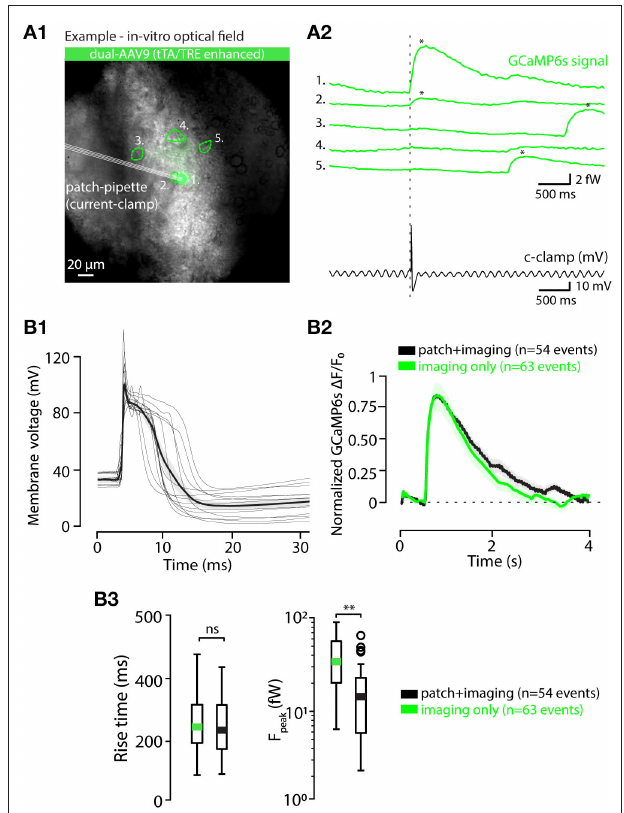
FIGURE 6 | Calcium event waveforms do not differ between patched and intact neurons. (A) Example of a combined in vitro patch-imaging experiment. (A1) shows an infrared-contrast image overlaid with standard deviation projection of fluorescence recording time series, and 5 somata identified in the field of view are indicated with dashed lines (ROIs). Cell labeled 1 was recorded with a patch-clamp pipette. (A2) shows the GCaMP6s signals obtained from all of the 5 cells in the field of view (green traces, ROIs indicated with numbers), and the time-aligned electrical recording from cell 1 (black trace). (B) Comparison of calcium event waveforms in patched (black) cells and intact (green cells). (B1) Time-aligned action potential waveforms from all 14 patched cells, aligned at calcium-event onsets. Thick black trace is the average of all spikes. B2, averaged, onset-aligned and normalized calcium event waveforms peak with shaded areas denoting ± SEM. (B2) Comparison between rise times (left) and peak amplitudes (right) of calcium events recorded in patched and intact cells. Green and black bars in box plots represent averages; circles represent outliers. Statistics for eCa event Rise-time between patched and non-patched neurons on (B3) (1-way ANOVA, f = 0.085, p = 0.77). Statistics for eCa event peak amplitude between patched (n = 46 events on 13 neurons) and non-patched neurons on (B3) (1-way ANOVA, f = 11.09, p =